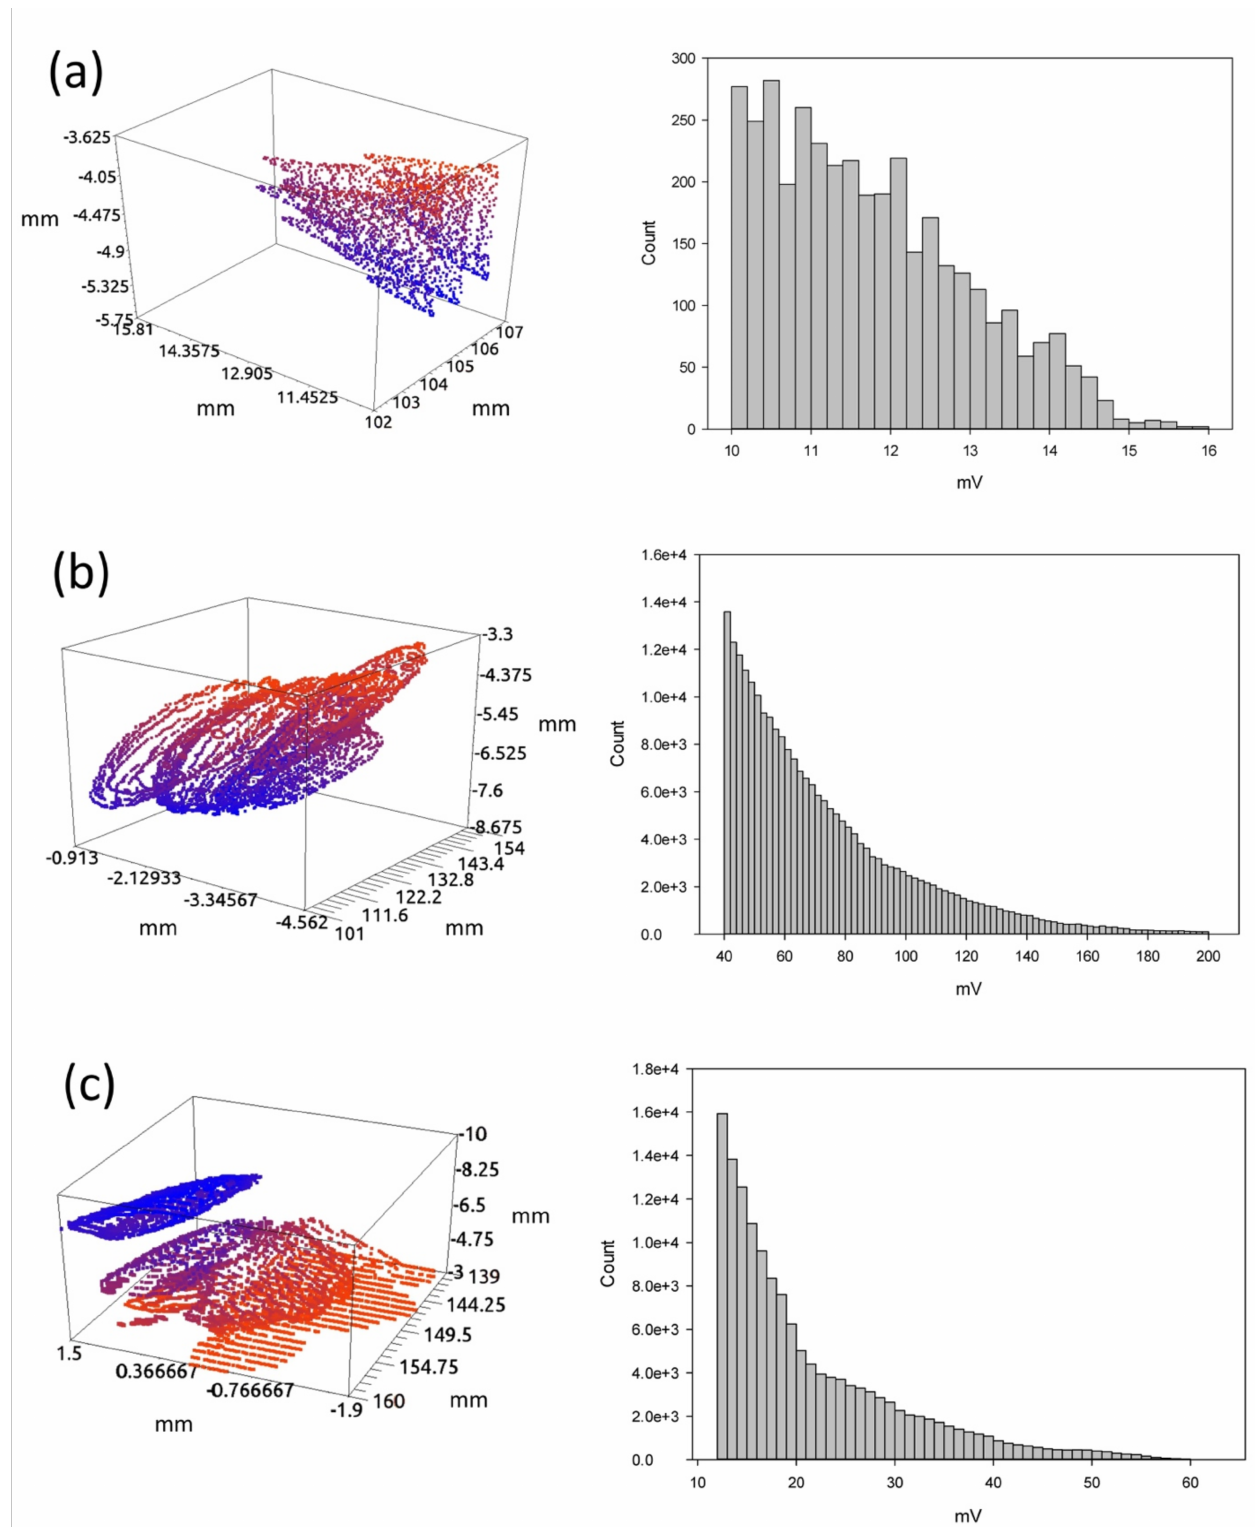
Figure 6. Three-dimensional reconstruction of ( a ) a pore (F1–11), ( b ) slag intrusion (F2–02) and ( c ) crack (F3–13). The three-dimensional reconstructions are on the left and the corresponding histograms are on the